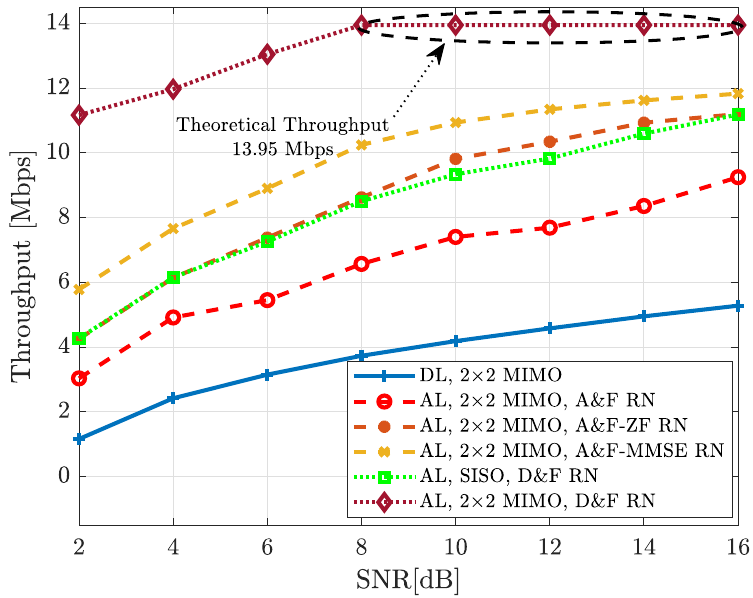
Figure 14. Achievable throughput comparison of the implemented RNCS with a conventional MIMO